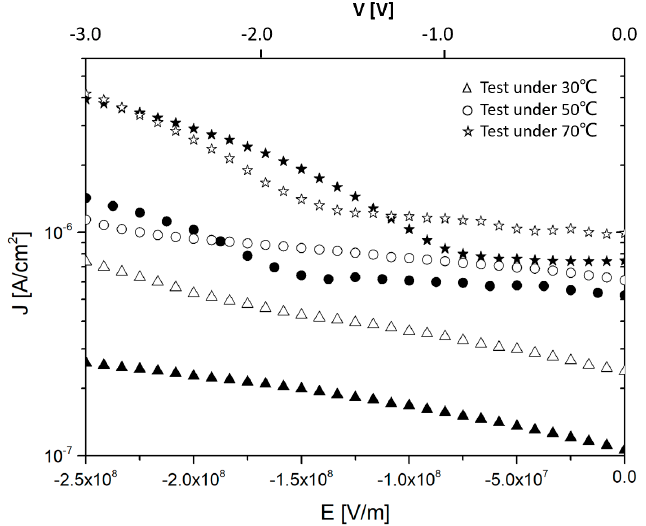
Figure 1. The leakage current measurement of the Au-Pt-Ti / HfO 2 -Al 2 O 3 / InAlAs MOS-capacitors under reversed bias condition at different temperatures. The solid symbol is for Sample #1 with HfO 2 (4 nm) / Al 2 O 3 (8 nm) laminated dielectrics, and the hollow symbol is for Sample #2 with HfO 2 (8 nm) / Al 2 O 3 (4 nm) laminated dielectrics.